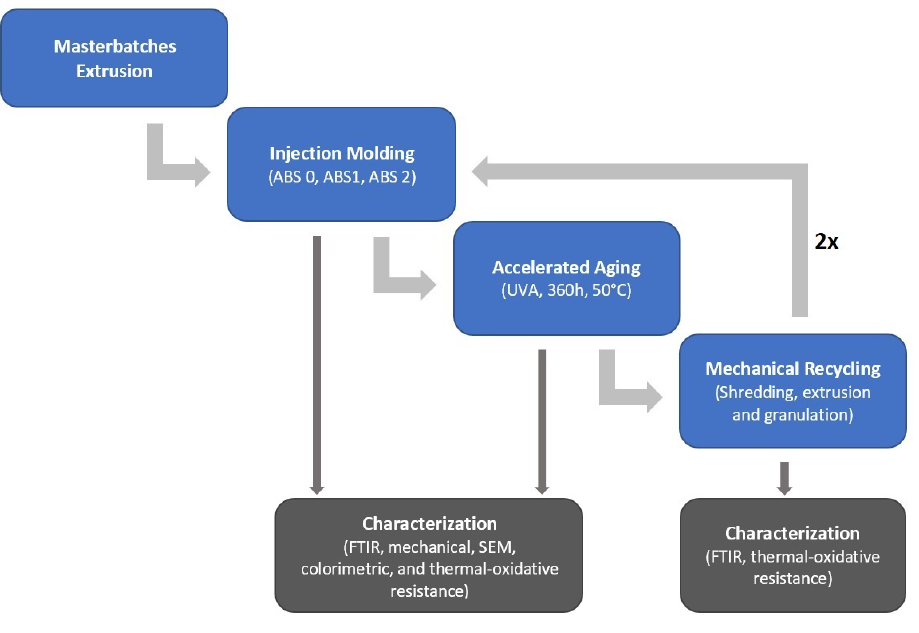
Figure 1. Research process flow chart to study the impact of various stabilization systems as combined with commercial ABS polymer (Table 1) after several accelerated aging and mechanical recycling steps.